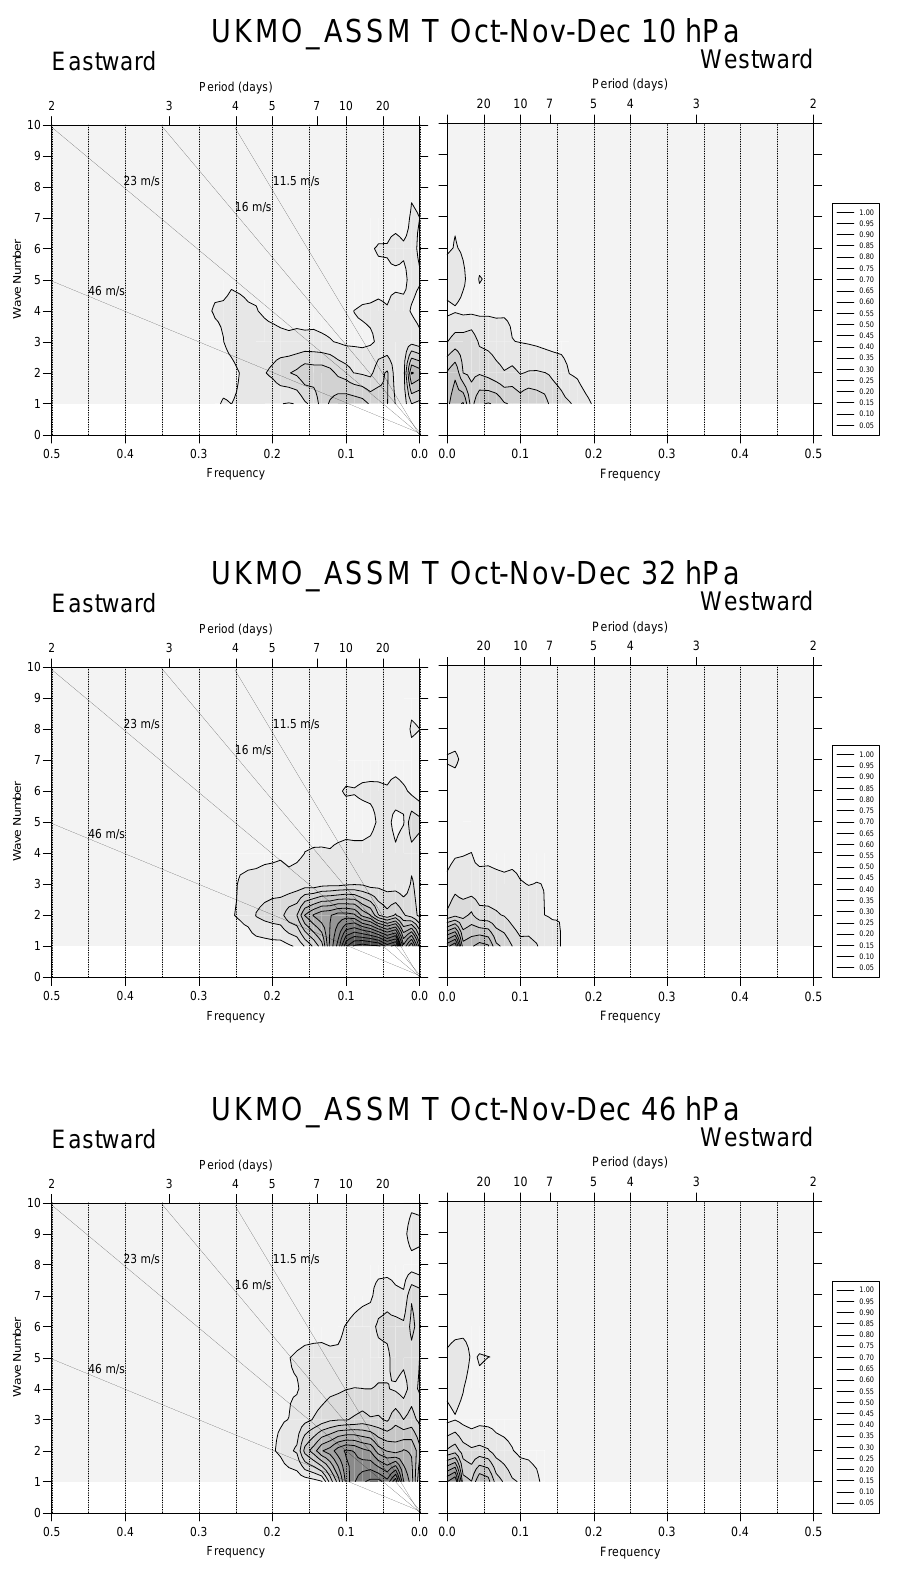
Fig. 5. Frequency-wavenumber power spectrum of the temperature field of the UK Met Office assimilated data, over the equator, for the time period October to December at 10 hPa, 32 hPa and 46 hPa. The contour interval is 0.05 K 2 day. Solid lines are theorical dispersion curves corresponding to different Kelvin waves phase speeds relative to the ground. The power spectrum is defined as in Fig.